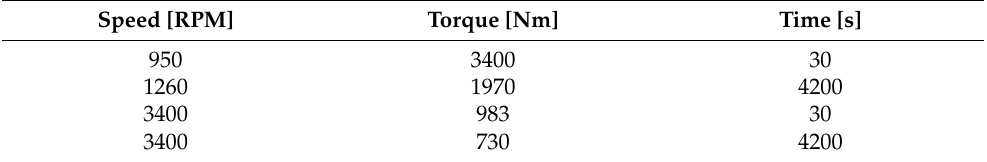
Table 4. SRM main operating targets.